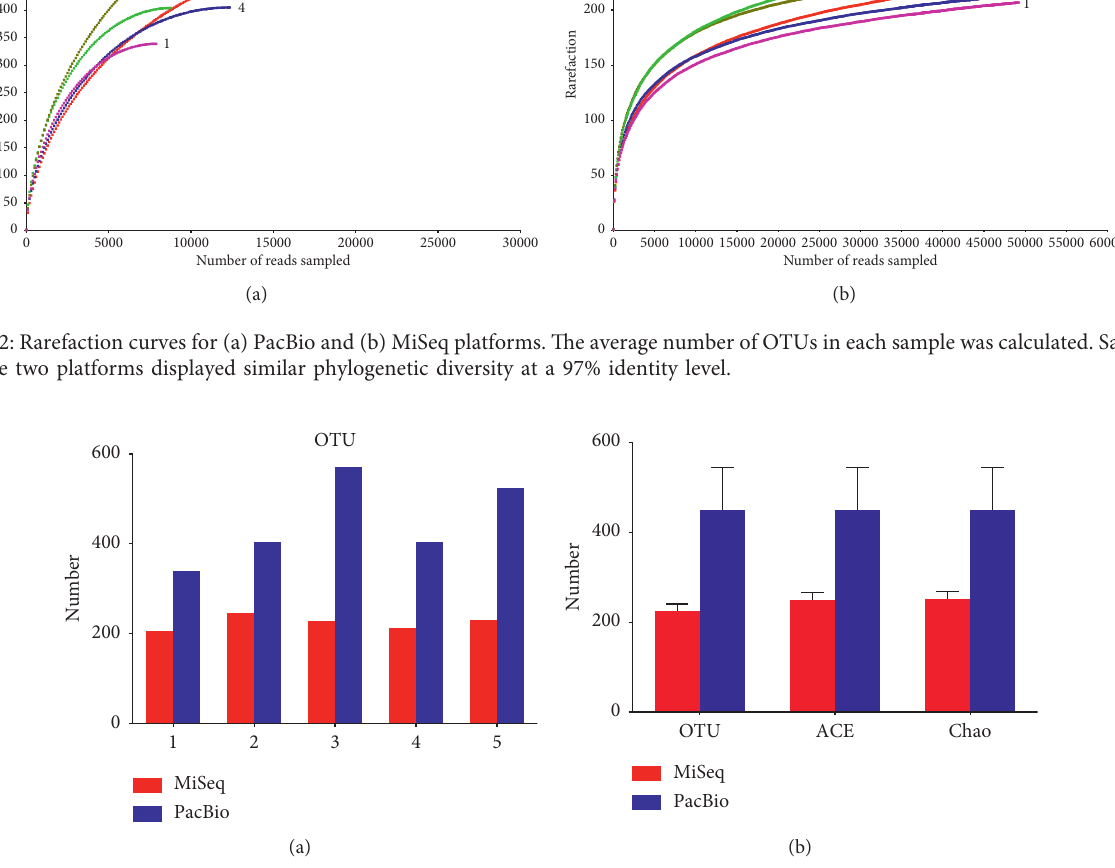
Figure 3: Richness of oral saliva. (a) OTU distribution of the 5 samples sequenced by MiSeq and PacBio platforms. (b) Comparison of OTU number and richness indices (Chao and ACE) between PacBio and MiSeq platforms. Different colors indicate different platforms.